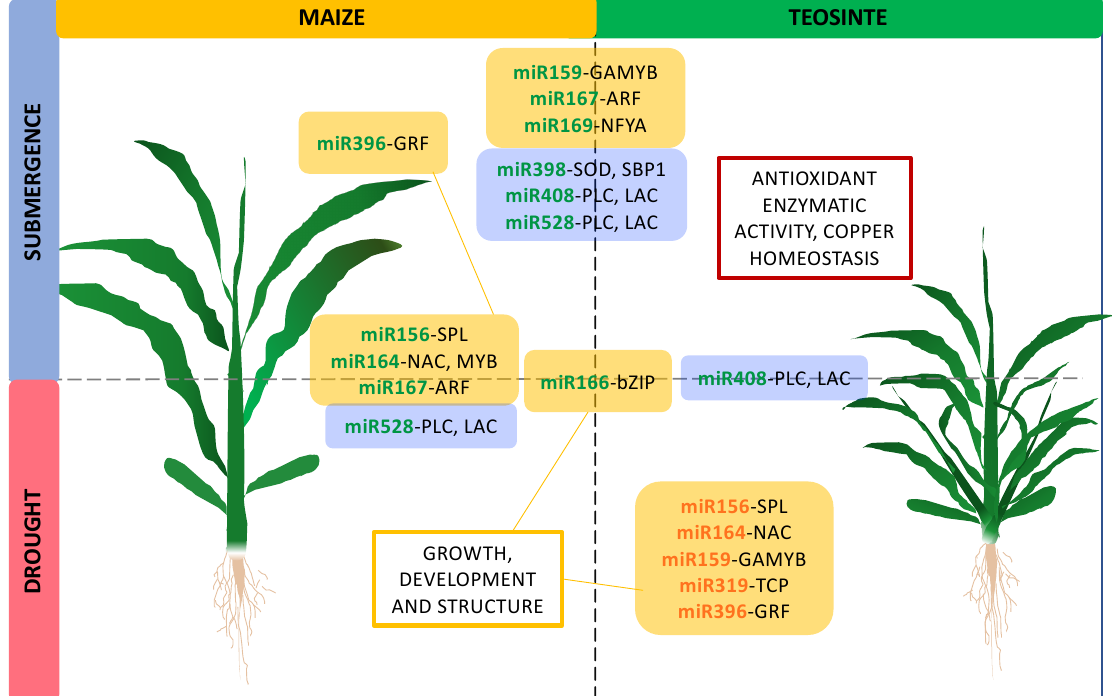
Figure 4. Hypothetical model of the regulation of miRNAs in the response to submergence and drought in maize and teosinte. The importance of antioxidant enzymatic activity, copper homeostasis, and control of growth and development as the main lines of response regulated by miRNAs in both plants is highlighted. Interrupted lines represent overlap between plants and / or